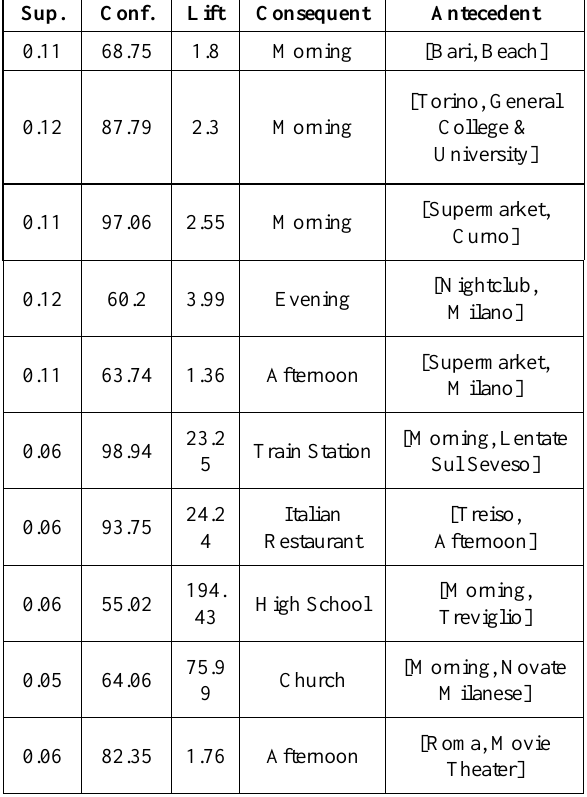
Table 5. A number of associated rules indicating socio-temporal characteristics of